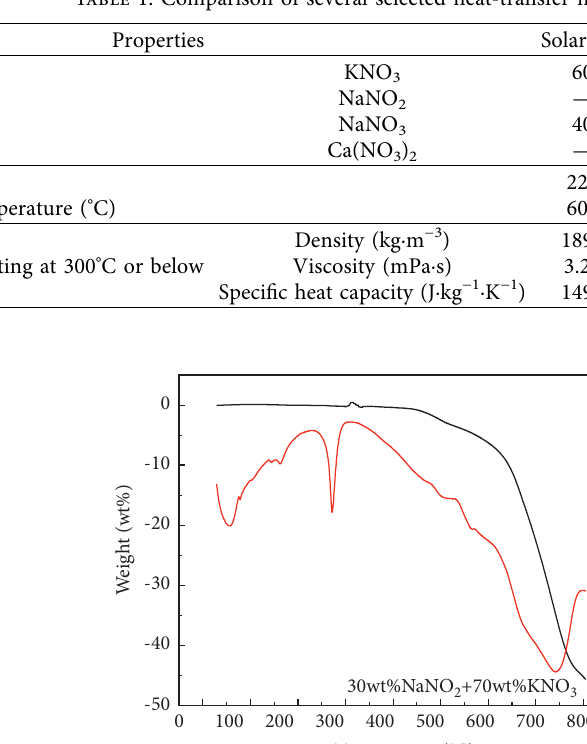
Figure 3: The schematic diagram of the heat-exchanging aluminum reduction cell developed by the Northeastern University of China [12, 13]. Table 1: Comparison of several selected heat-transfer mediums [14–16].